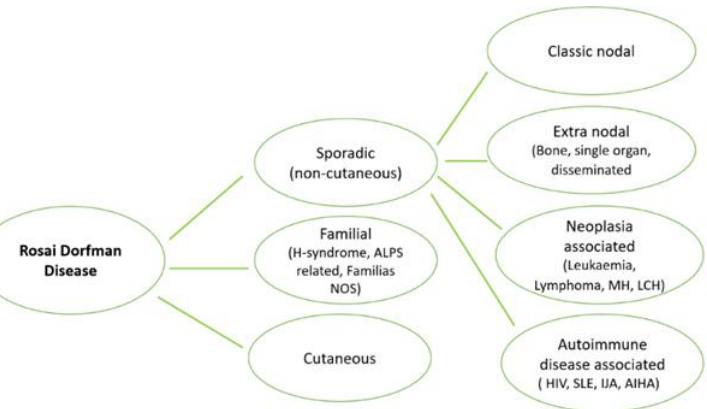
Figure 1. Addapted from Histiocyte Society, Rosai–Dorfman classification [3]. AIHA, autoimmune hemolytic anemia; ALPS, autoimmune lymphoproliferative syndrome; ECD, Erdheim–Chester disease; IJA, idiopathic juvenile arthritis; LCH, Langerhans cell histiocytosis; MH, malignant histiocytoses; NOS, not otherwise specified; SLE, systemic lupus erythematosus.